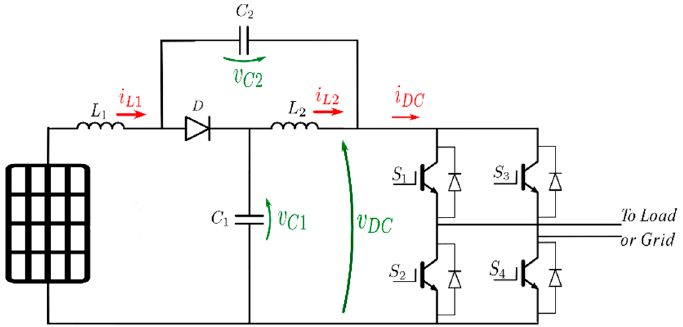
Figure 4. A single-phase qZSI.